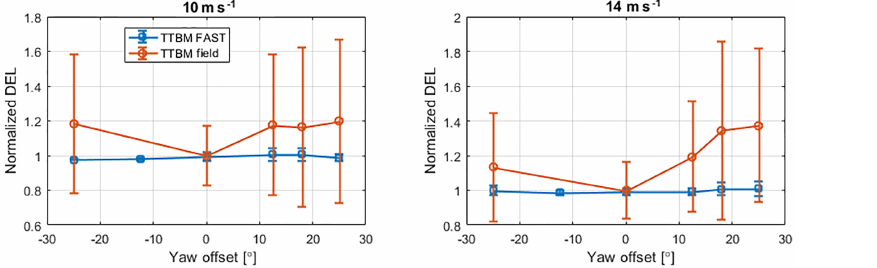
Figure A5. Comparison between predicted (FAST) and measured (field) TTBM DELs. The largest component among eight load-rose sectors was selected for each yaw offset.